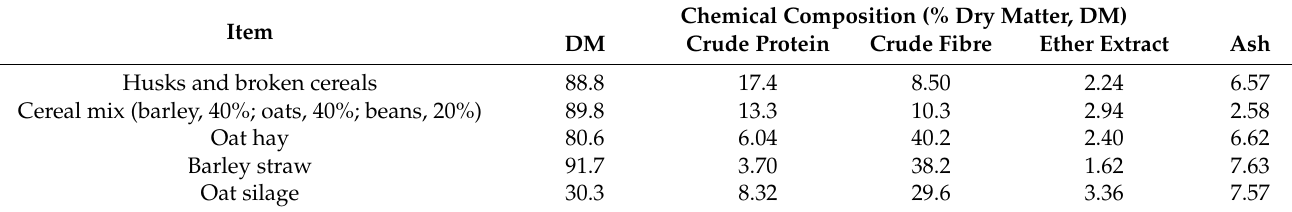
Table 1. Chemical composition of the main supplementary feeds during